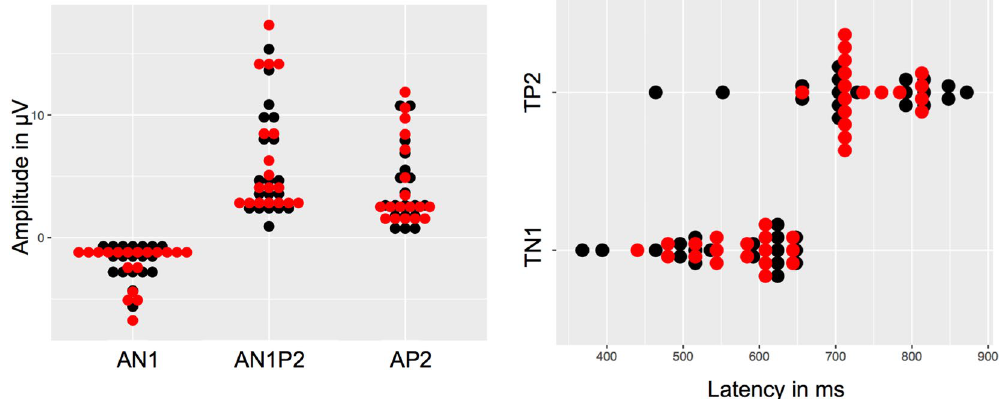
Figure 4. OERP representing cortical responses to ( + )-rose oxide and ( − )-rose oxide. The black and the red dots represent each participant’s electrophysiological response to R ( − ) and R ( + ). ( A ) Mean values (in μ V) of AN1, AN1P2 and AP2 amplitudes showing no significant differences between ( + )-rose oxide and ( − )-rose oxide. ( B ) Mean latencies (in ms) TN1 and TP2 in response to ( + )-rose oxide and ( − )-rose oxide with no significant